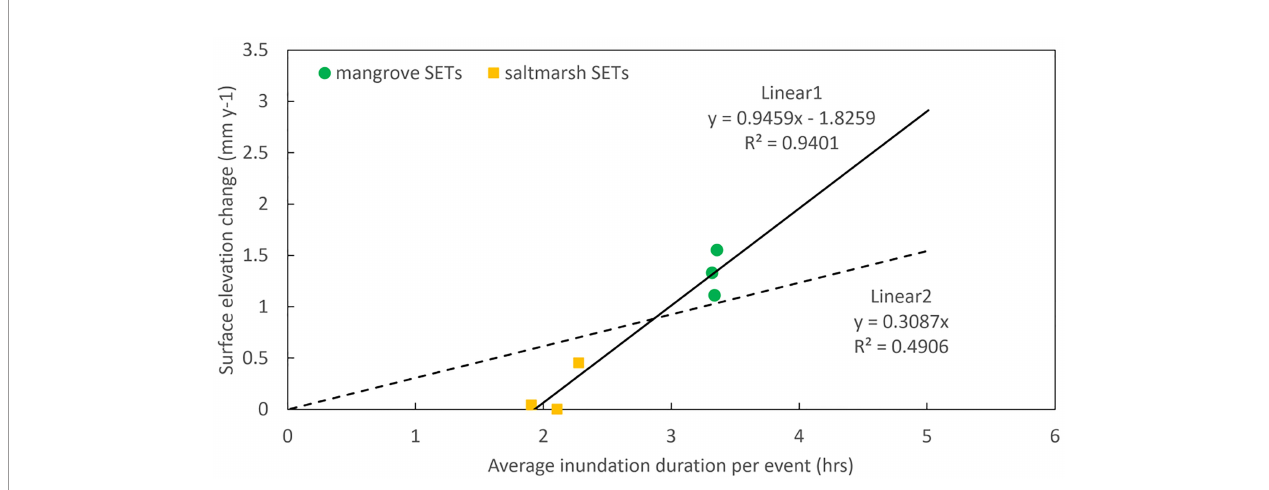
FIGURE 4 | Linear relationship between modelled average inundation duration per inundation event (hours) and wetland surface elevation change (mm yr -1 ). Green and orange symbols are based on the six SETs with the orange squares being saltmarsh sites and the green circles representing the mangrove